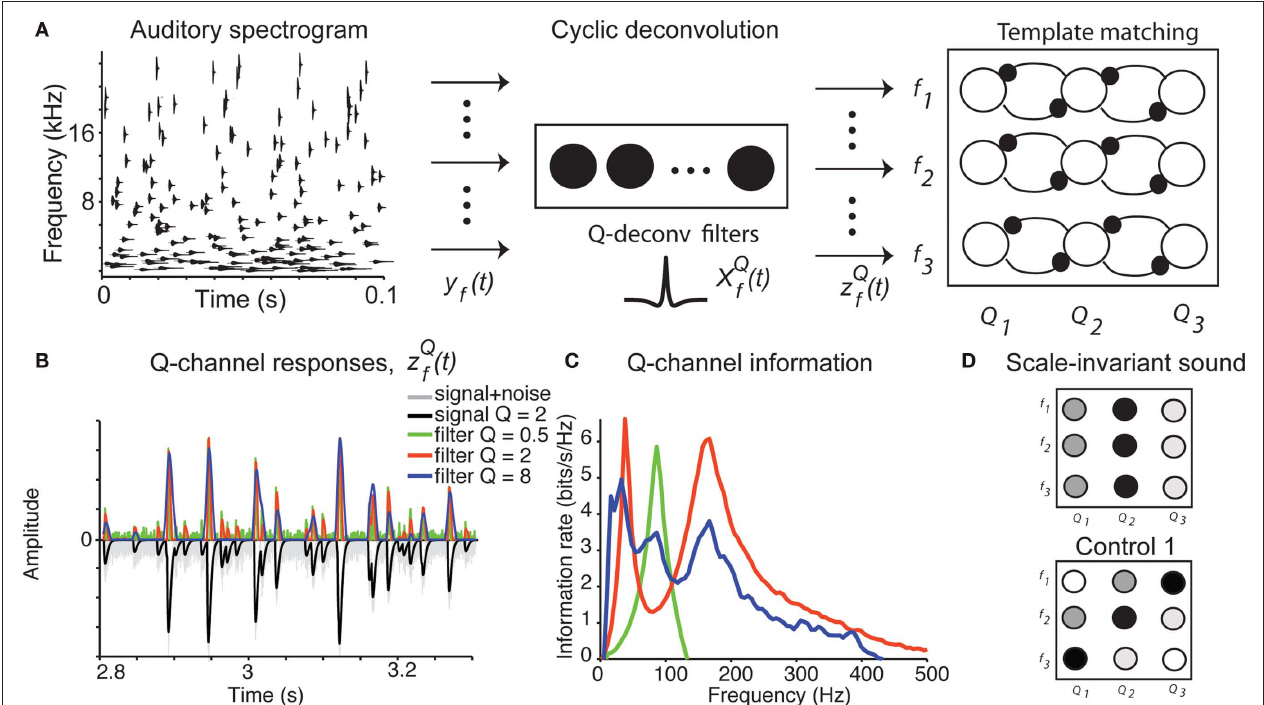
neighboring peaks, and output for filter with Q = 0.5 misses the peaks because of the noise. (C) The deconvolving filter with matching Q relays the most information about the original signal. The information rate of the output of stage 2 of the model as in (B) . Note that the red trace ( Q = 2) depicts a greater information content transmitted by the matching deconvolving filter. The green trace ( Q = 0.5) exhibits most power in the noise band. The blue trace ( Q = 8) exhibits lower information than the red trace over all frequency bands. (D) Examples of cyclo-spectral templates: Predicted mean activation of cyclo- spectral ( Q–f) channels. Sounds with constant Q across spectral bands, such as the naturally perceived sounds with Q = 2, will activate predominantly the channels of the same Q across spectral channels. Sounds from control 1, composed of chirps whose temporal structure is constant, activate the channels with varying Q across spectral bands: Q will be higher for